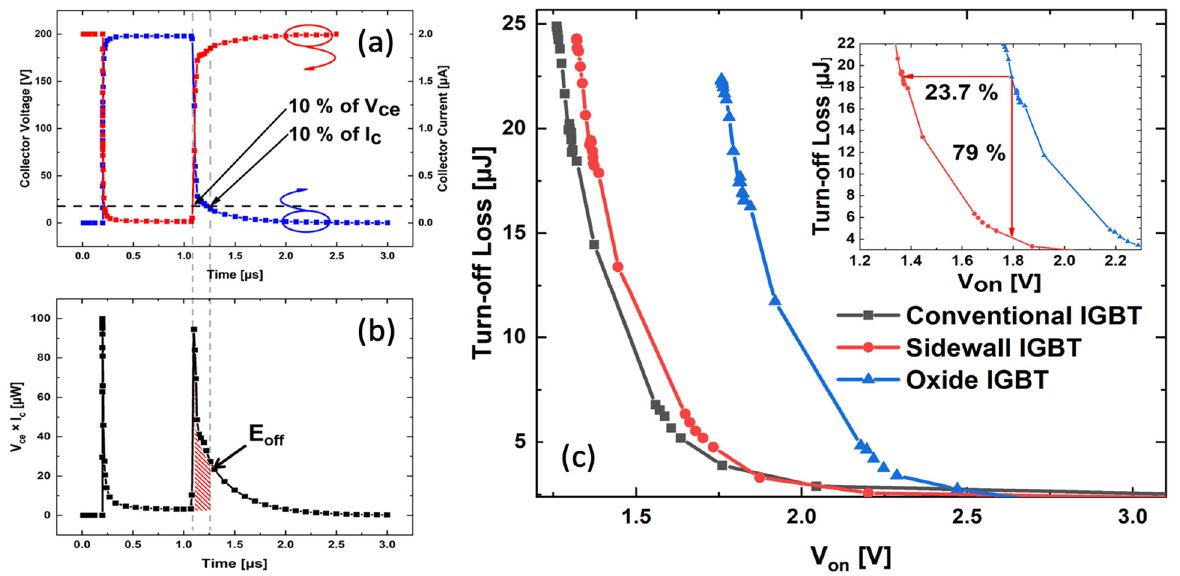
Figure 6. The method to calculate the turn-off loss: ( a ) turn-off waveform of collector voltage, collector current and ( b ) power dissipation. ( c ) Turn-off loss curves between the C-IGBT, S-IGBT and O-IGBT at T = 300 K.